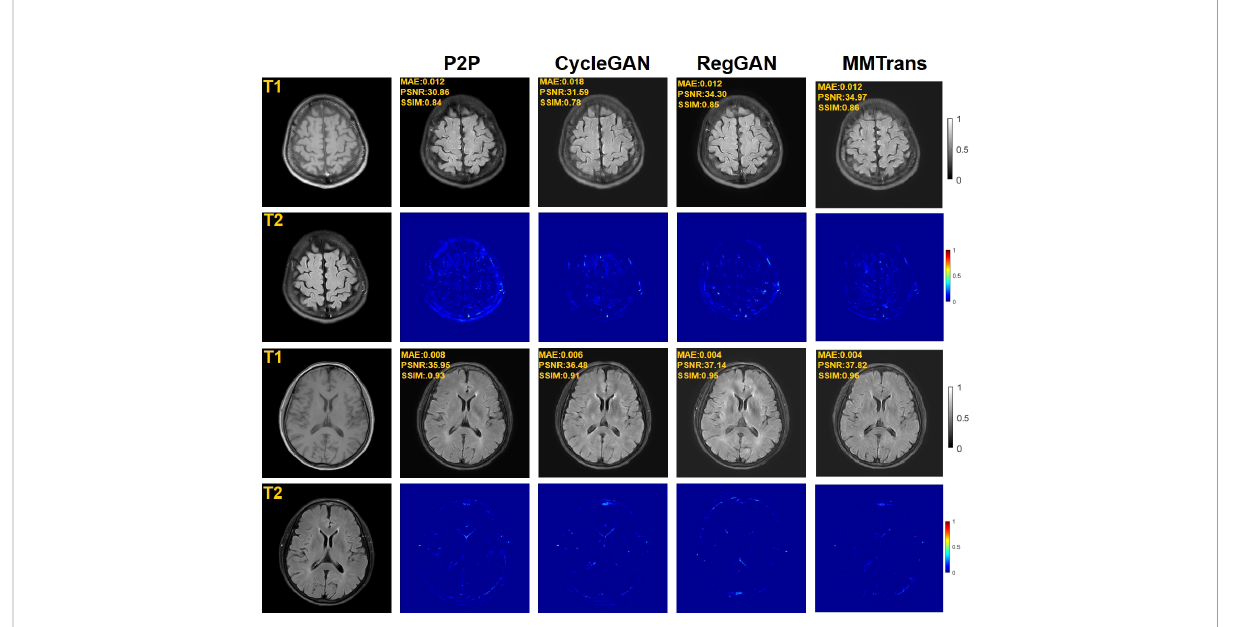
FIGURE 5 Qualitative results of different translation methods for translating T2 from T1 using the paired clinical brain MRI dataset, showing translation images and corresponding error maps.